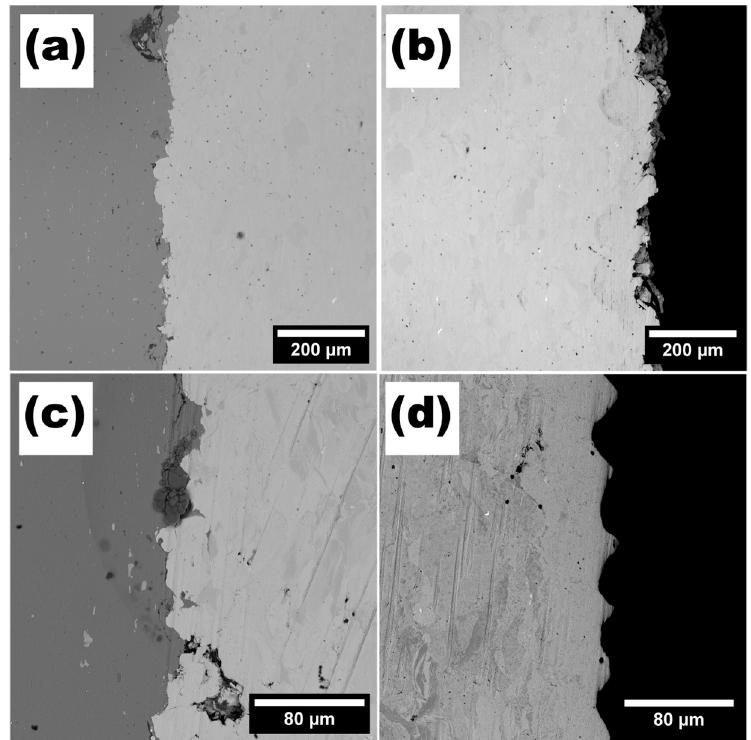
Figure 8. Cross-sections of ( a ) Ti-0 aluminium–titanium junction, ( b ) Ti-0 titanium layer, ( c ) Ti-1 aluminium–titanium junction, ( d ) Ti-1 titanium laser-modified layer.